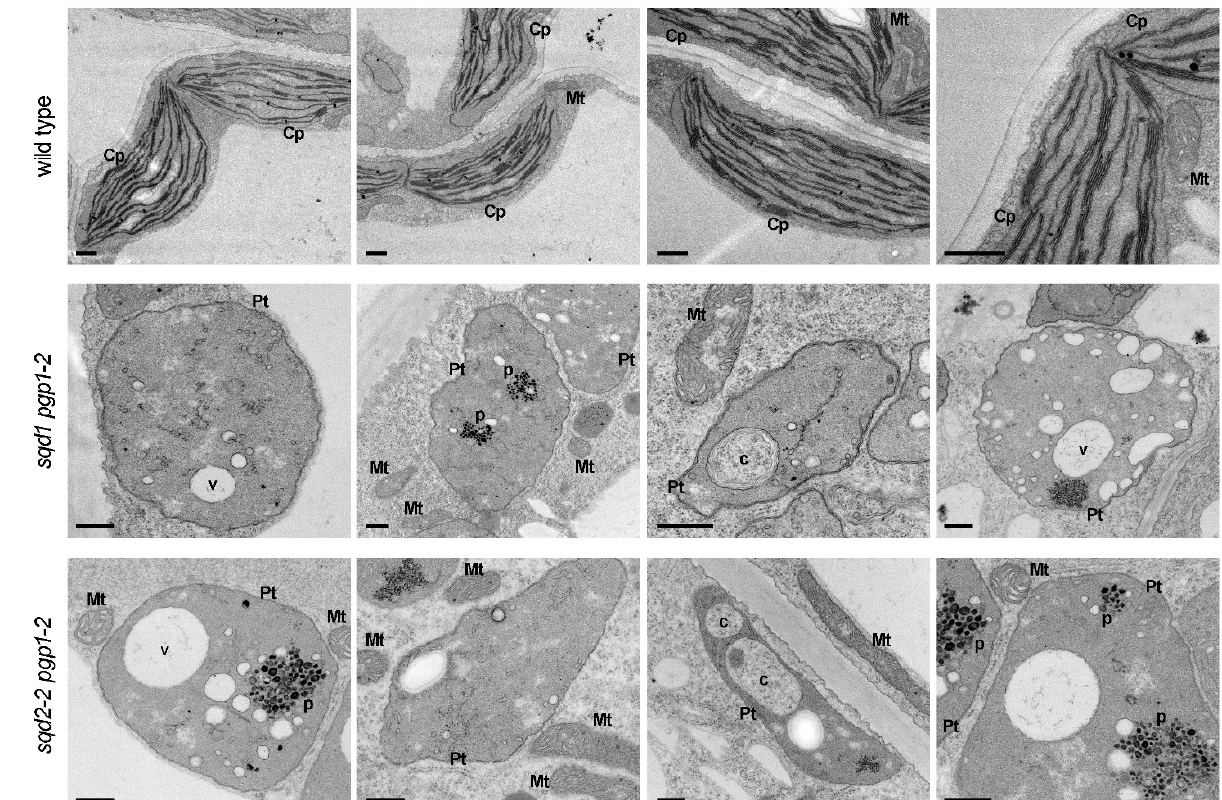
Figure 6. Ultrastructures of plastids and mitochondria in leaves of sqd1 pgp1-2 and sqd2-2 pgp1-2 mutants grown for 21 d. The structure of these organelles in wild-type leaves was shown for reference. Cp, chloroplast; Pt, plastid; Mt, mitochondrion; c, cytosol-like structure; p, plastoglobule; v, vacuole-like structure. Scale bars = 500 nm.